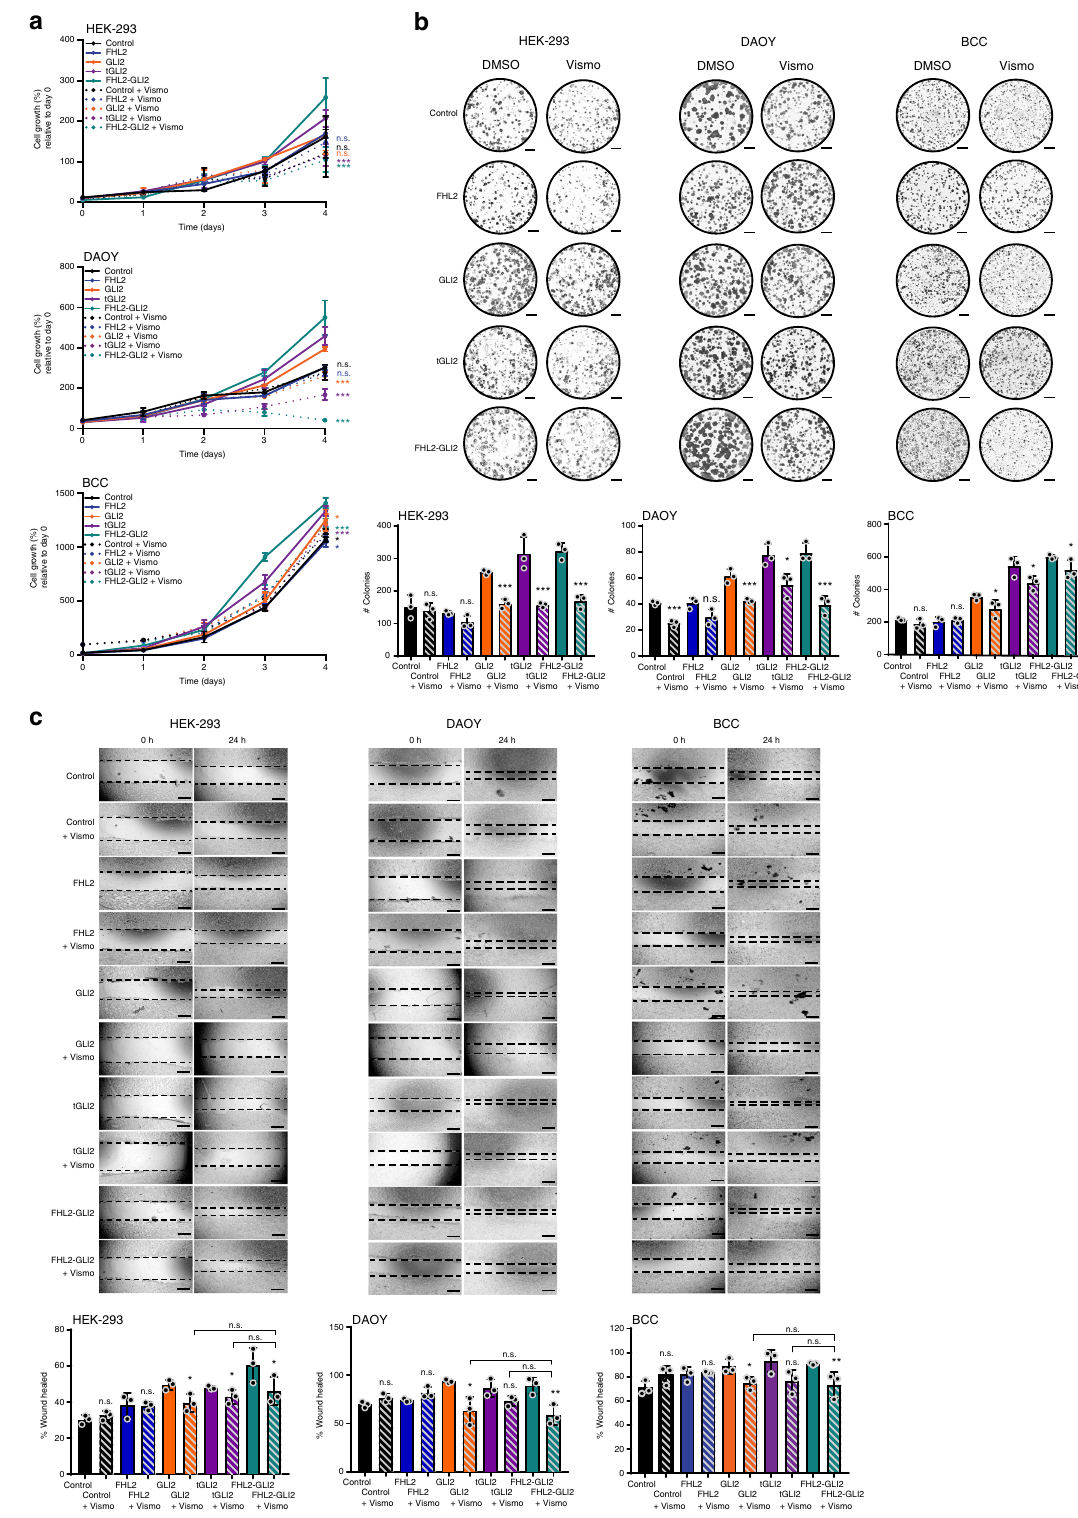
Reverse transcription PCR (RT-PCR) for fusion validation . Total RNA was reverse-transcribed using SuperScript VILO Master Mix (Life Technologies; Thermo Fisher Scienti fi c), according to the manufacturer ’ s instructions. PCR ampli fi cation of 10 ng of cDNA was performed using speci fi c primer sets designed based for each fusion gene and each breakpoint (Supplementary Table 3) 51 . PCR fragments were puri fi ed (ExoSAP-IT, Affymetrix) and sequenced on an ABI 3730 capillary sequencer using the ABI BigDye Terminator chemistry (v3.1, Life Technologies) according to the manufacturer ’ s protocol. Sequences of the